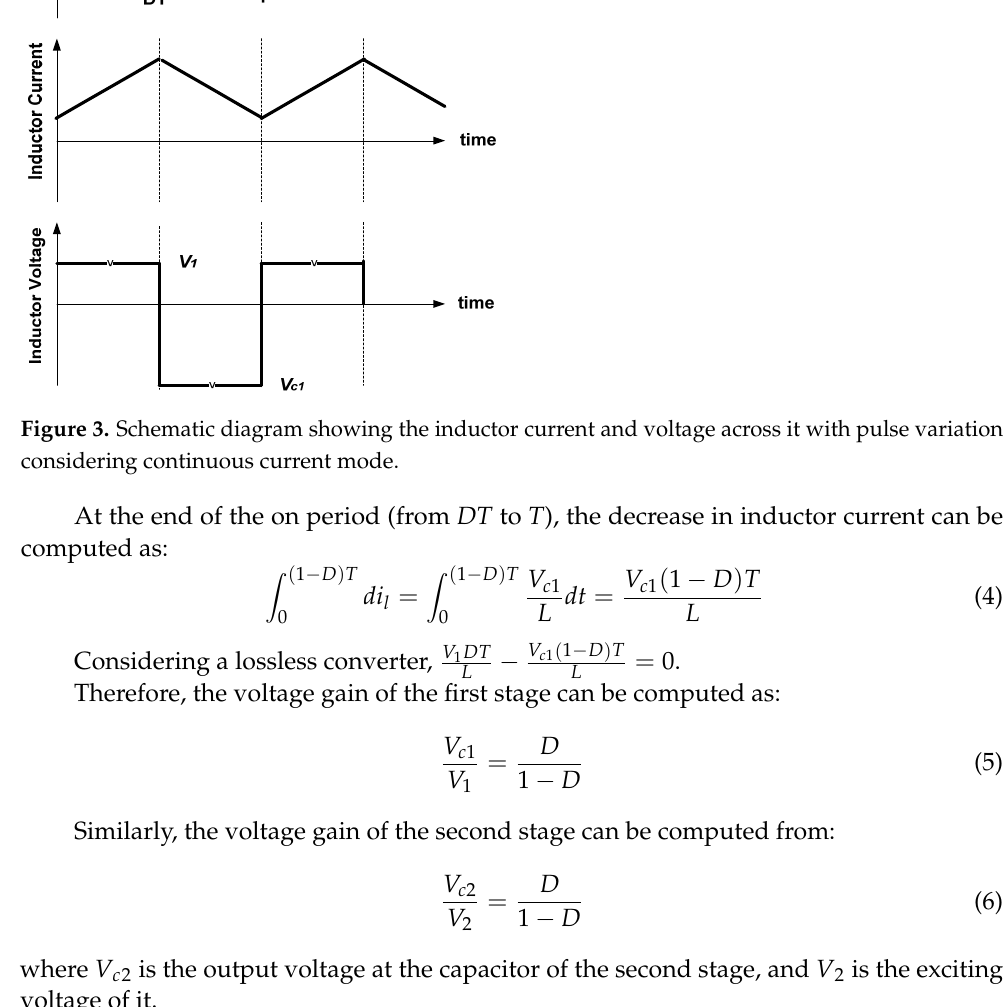
Figure 4. Variation of voltage gain with duty ratio at different number of converter stages.